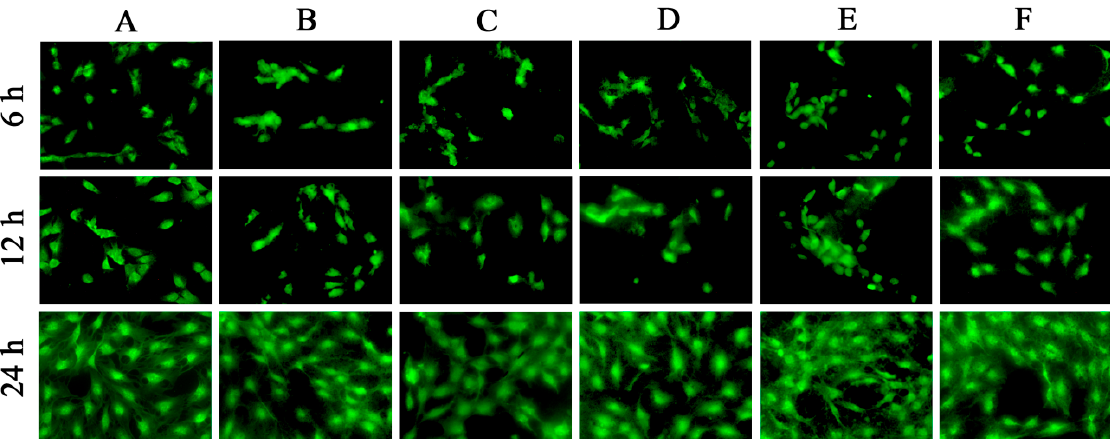
rate 5.93%) cultured with MC3T3-E1 cells for 24 h by gradient dilution (* p < 0.05). tured with MC3T3-E1 cells for 24 h by gradient dilution (* p < 0.05).